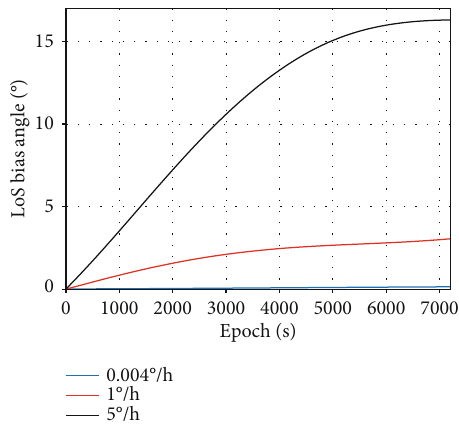
Figure 10: LoS vector bias angle for di ff erent gyroscope biases.